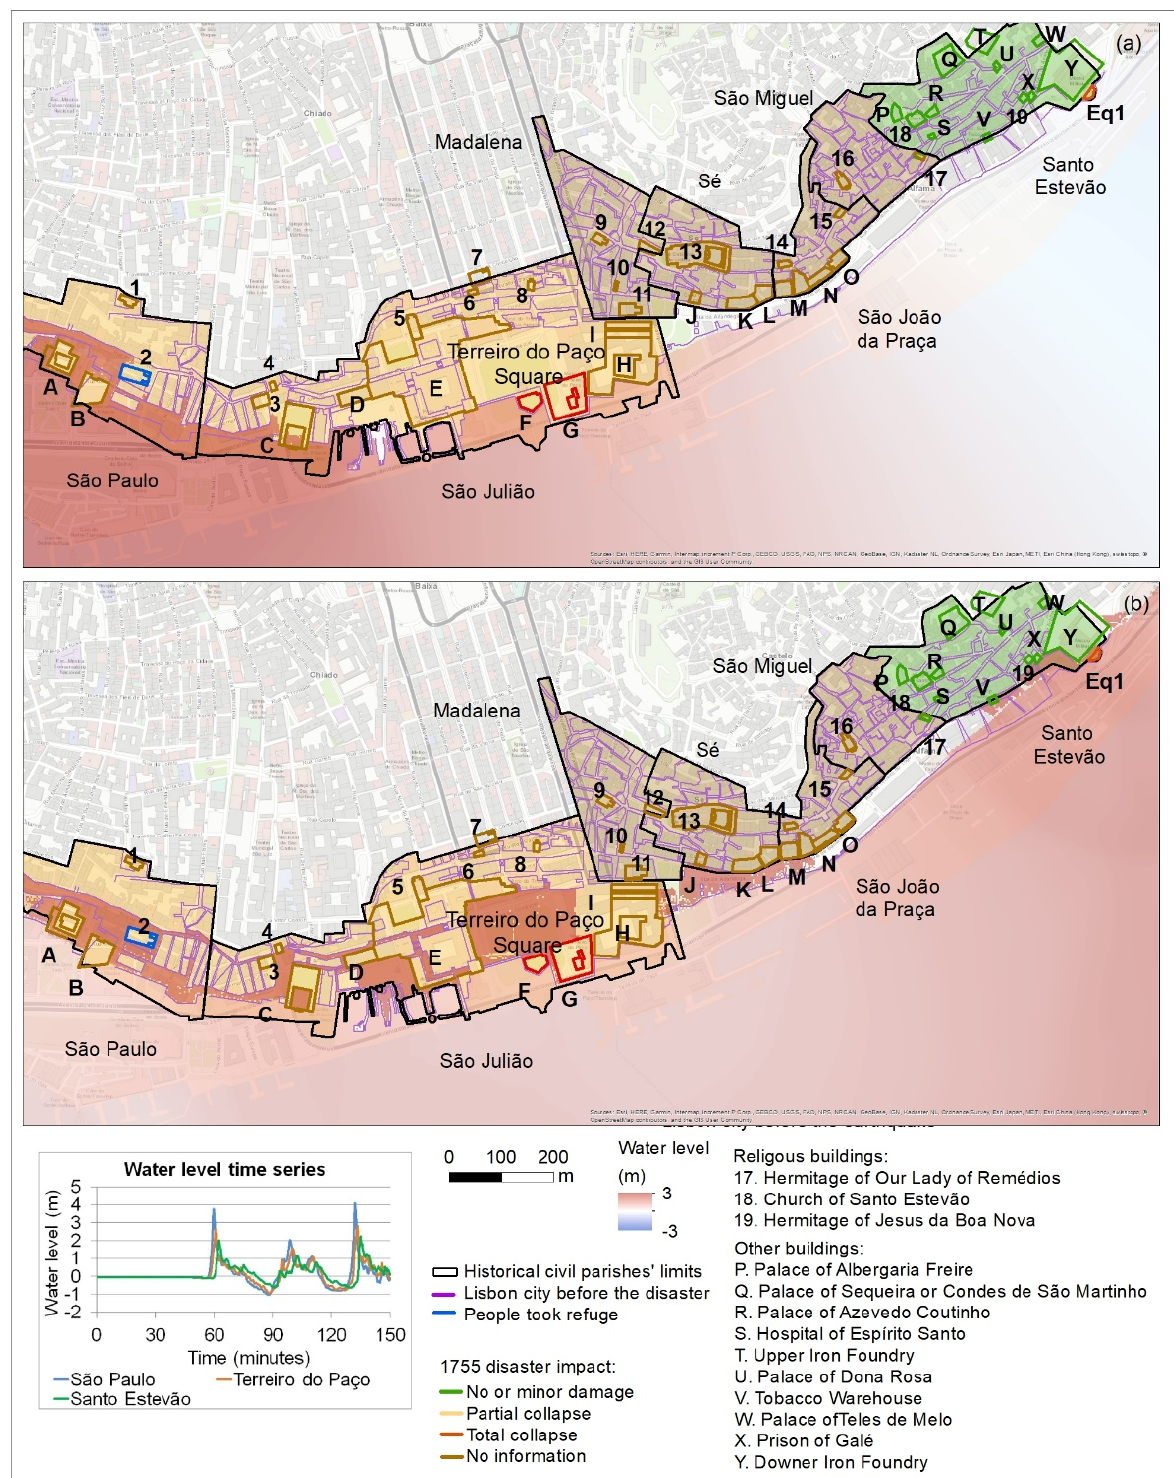
Figure 9. Tsunami water level snapshots’ results on computational region six, corresponding to the arrival of the first and third waves: ( a ) 60 min; ( b ) 130 min. Also presented in the Figure is the plot of the water level time histories. List of buildings in civil parishes of S ã o Paulo, S ã o Juli ã o, Madalena, S é , S ã o Jo ã o da Praça, and S ã o Miguel are presented in Figure 2, while buildings of Santo Estev ã o are indicated in Figure 4. The present-day layout of the city is presented on the